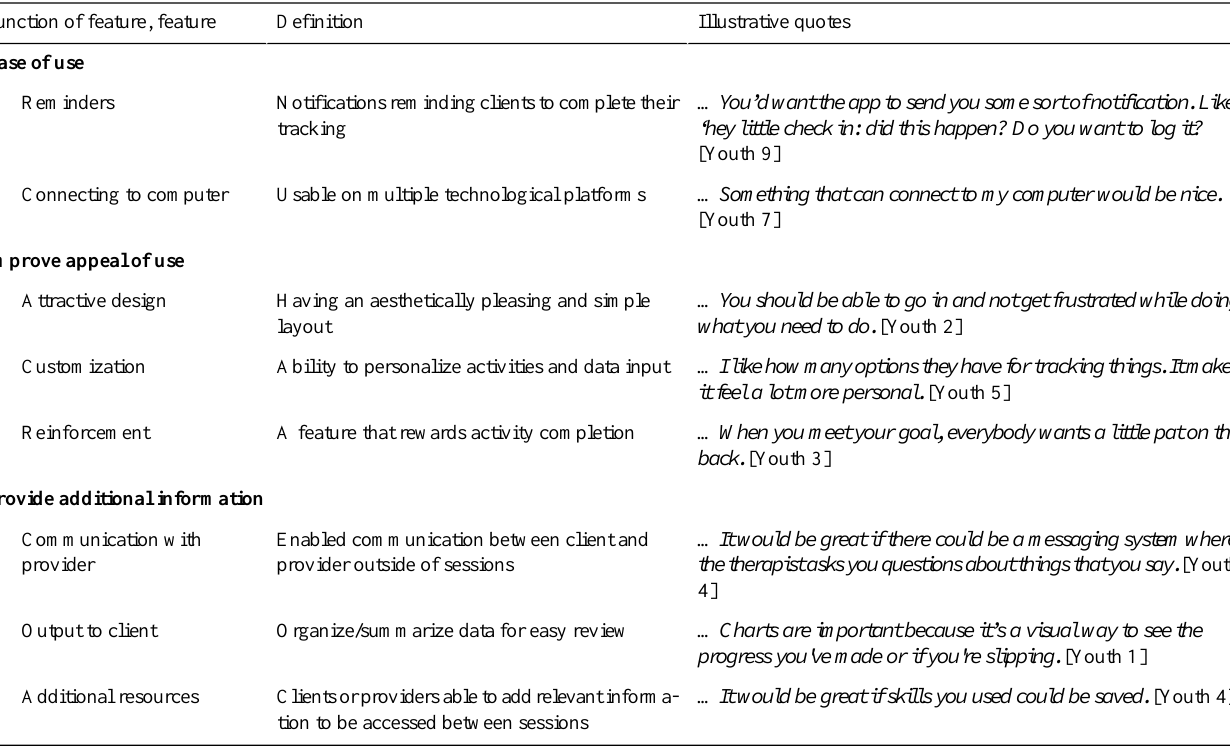
Table 3. Summary of the suggestions provided by the youths for mobile health app features.